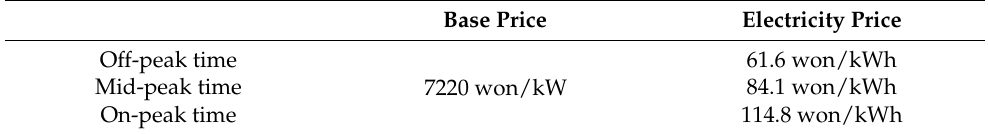
Table 8. Electricity price according to time.